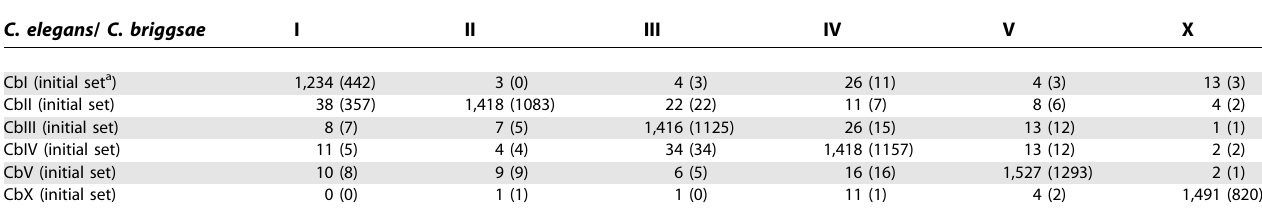
Table 4. Reciprocal Mapping of 1:1 Orthologs C. elegans / C.